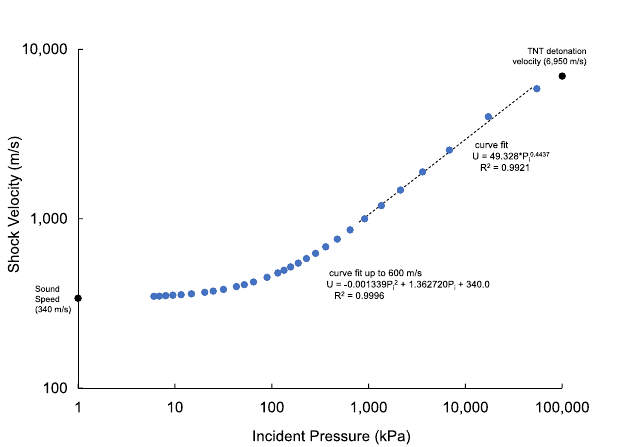
Figure 2. Shock wave velocity versus incident overpressure.